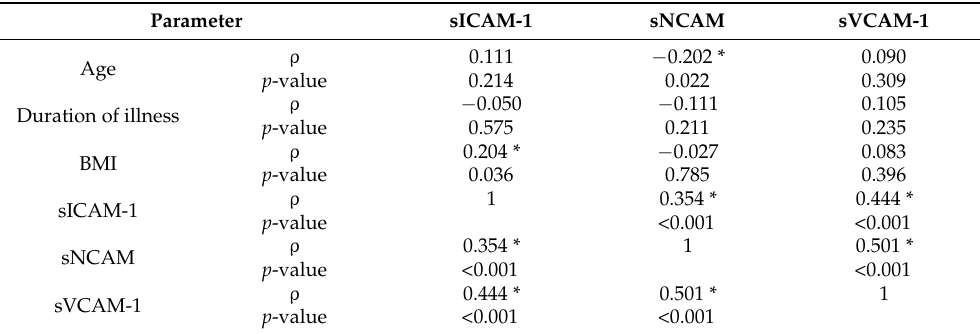
Table 4. Spearman’s analysis of correlation between CAMs, age, duration of schizophrenia, and BMI among patients without